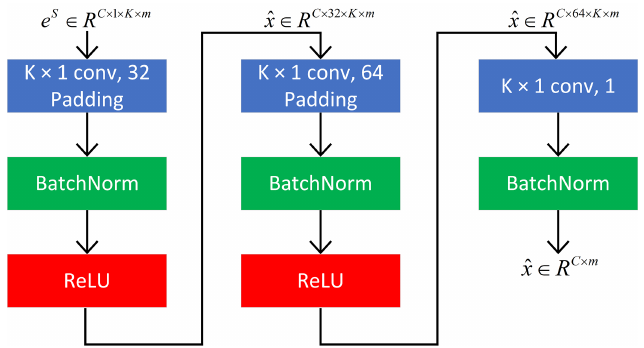
Figure 5. Structure of convolutional prototype induction module g